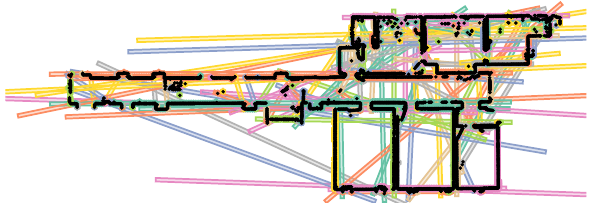
Figure 1. Lines extracted by Min-hashed J-Linkage, depicted with their inlier